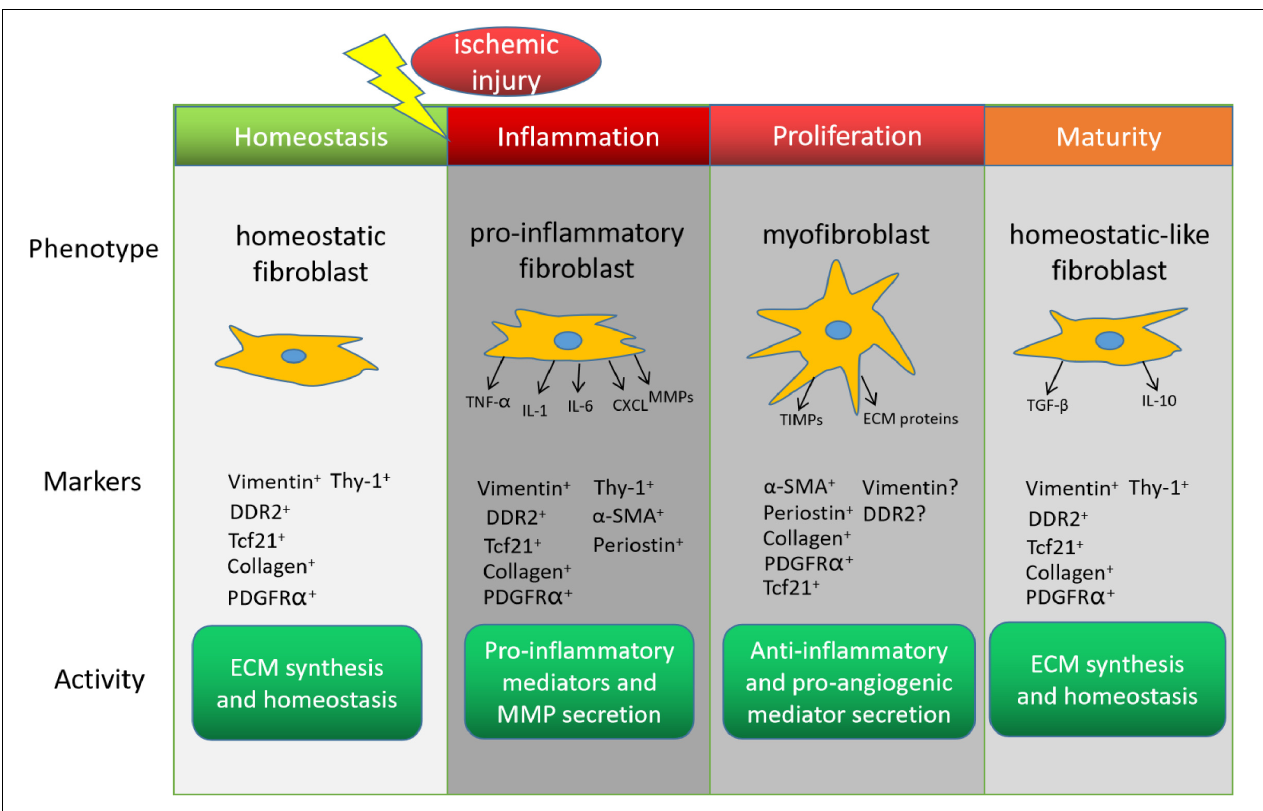
FIGURE 1 | Cardiac fibroblasts (CFs) in the endogenous response to myocardial infarction. The phenotype, marker expression, and activity of CFs change during recovery from myocardial infarction. DDR2, discoidin domain receptor tyrosine kinase 2; Tcf21, transcription factor 21; PDGFR α , platelet-derived growth factor receptor α ; α -SMA, α smooth-muscle actin; TNF- α , tumor necrosis factor α ; IL, interleukin; CXCL, C-X-C motif ligand; MMP, matrix metalloproteinase; ECM, extracellular matrix; TIMP, tissue inhibitors of metalloproteinase; TGF- β , transforming growth factor β